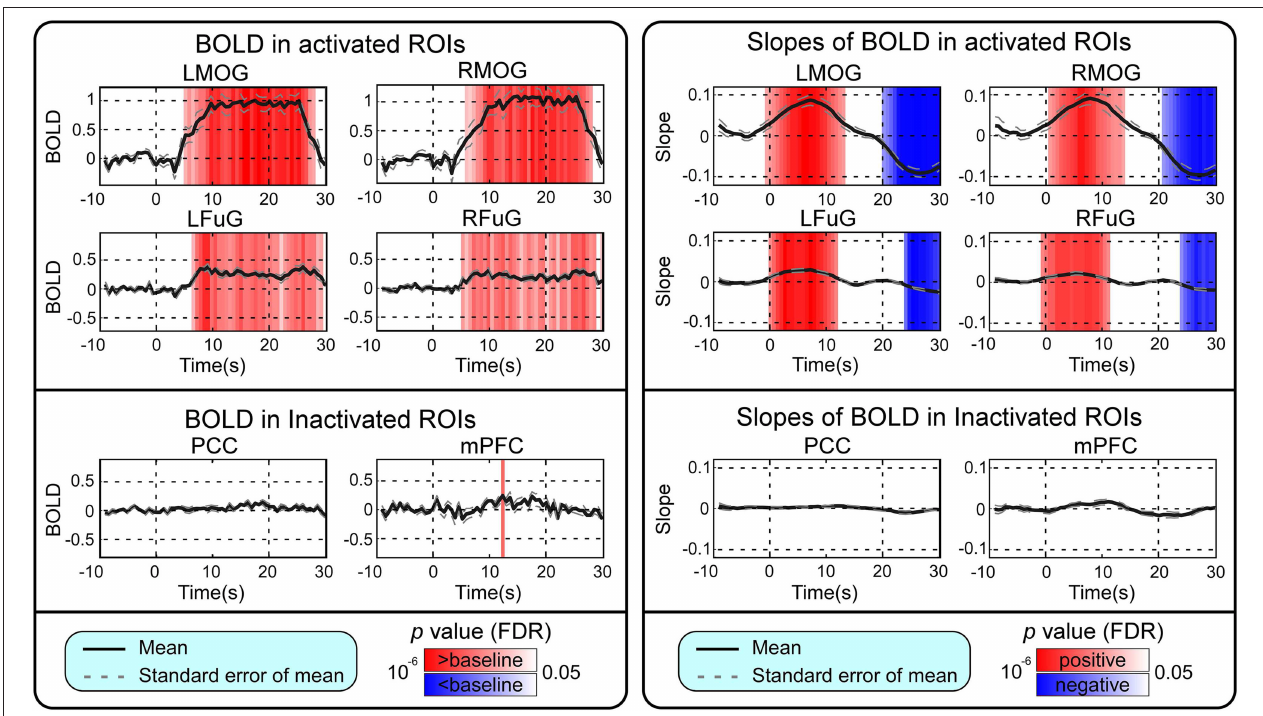
FIGURE 2 | Left: Mean and standard error of mean (SEM) of BOLD responses in four activated ROIs and two inactivated ROIs. Two-tailed t -test was used to examine whether the BOLD after stimulus onset was larger or smaller than baseline at each time point. The time points with significantly larger or smaller ( p < 0.05 , FDR corrected) BOLD responses than baseline were highlighted with red or blue background, respectively. Right : Mean and SEM of slopes of BOLD in four activated ROIs and two inactivated ROIs. Two-tailed t -test was used to examine whether the slope of BOLD was larger than 0 or smaller than 0 at each time point. The time points with significantly positive or negative ( p < 0.05 , FDR corrected) slope values were highlighted with red or blue background, respectively. Stimulation period was from 0 to 20s. Results were averaged across three blocks and all